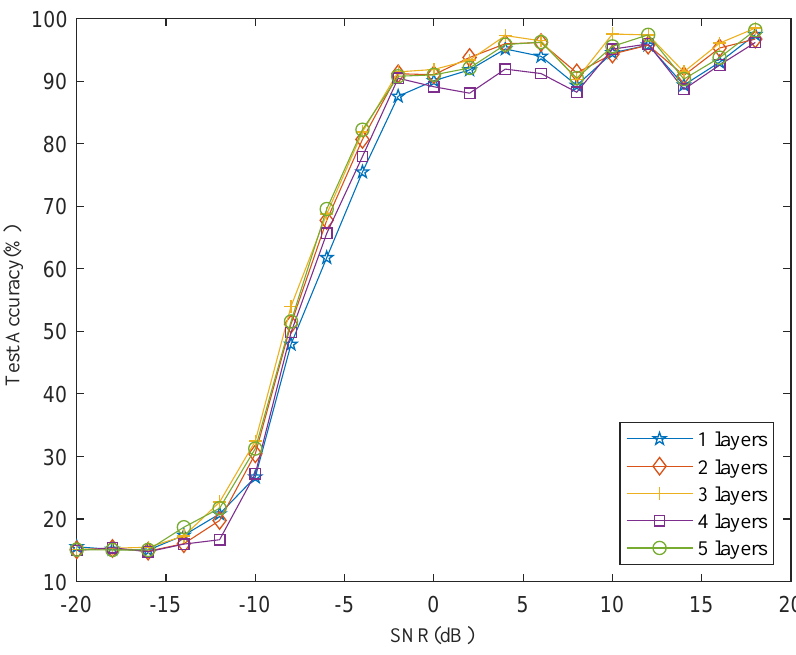
Figure 11. Recognition accuracy of different number of convolution layers.